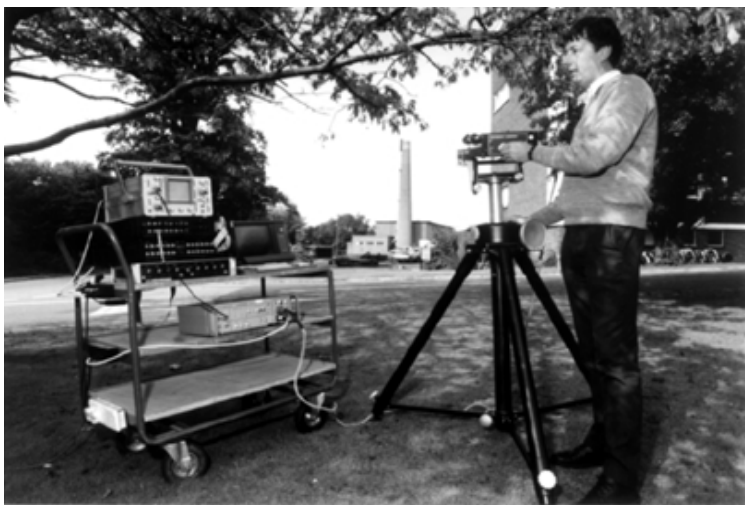
Fig. 1. Laser interferometer in